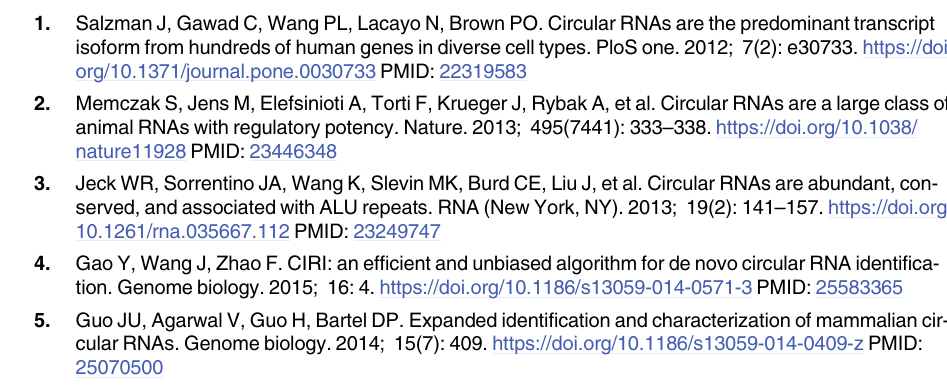
S3 Table. Result of Conservation analysis. (A) Result of Conservation analysis between maize and rice. (B) Result of Conservation analysis between maize and Arabidopsis Thaliana . (C) Result of Conservation analysis between maize and Soybean. (D) Result of Conservation analysis between maize and tomato. S4 Table. Primers used to validate maize circRNAs. (A) Divergent primers for validation of candidate circRNAs. (B) Convergent primers for validation of candidate circRNAs. S5 Table. Correlation of circRNAs and their corresponding parent genes. S6 Table. Functional prediction of circRNAs originated from protein-coding genes indi- rectly. (A) CircRNAs and the function of their parent genes. (B) Enrichment of pathway analy- sis. S7 Table. List of circRNAs acting as miRNA decoys. miRNA were listed in the first column. CircRNA in the second column acting as the miRNA decoys. The following columns mean the starting and terminating sites between circRNA and miRNA, MFE of a perfectly matched site, MFE of the alignments, MFEsite/MFEperfect, respectively. MFE: minimum free energy. S8 Table. Gene Ontology (GO) and pathway analysis of circRNAs acting as miRNA decoys based on ceRNA hypothesis. (A) Enrichment of Gene Ontology analysis. (B) Enrichment of pathway